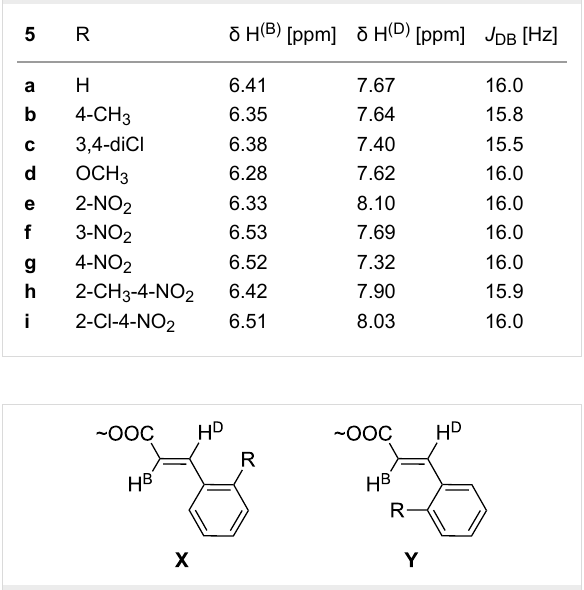
Figure 1: Conformations of the substituent in 2-position of the cinna- mates 5e , 5h , 5i .